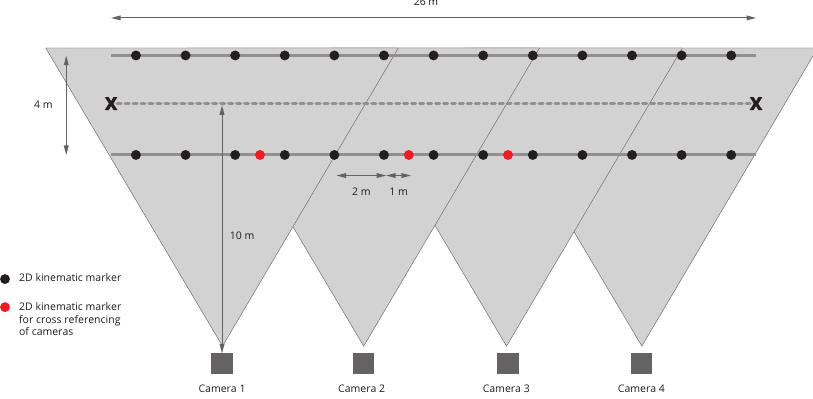
Figure 2. Field of measurement with 2D video cameras.